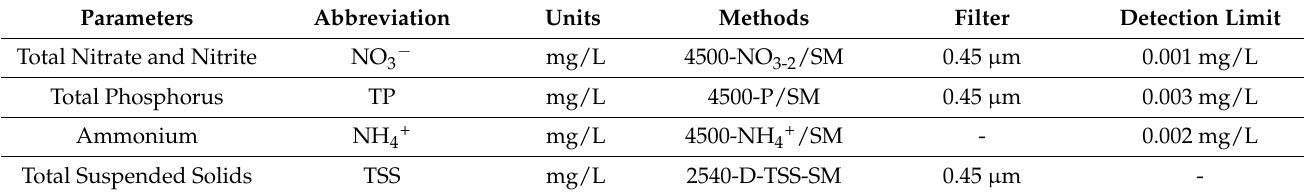
Table 1. List of the water quality methods used for each nutrient and total suspended